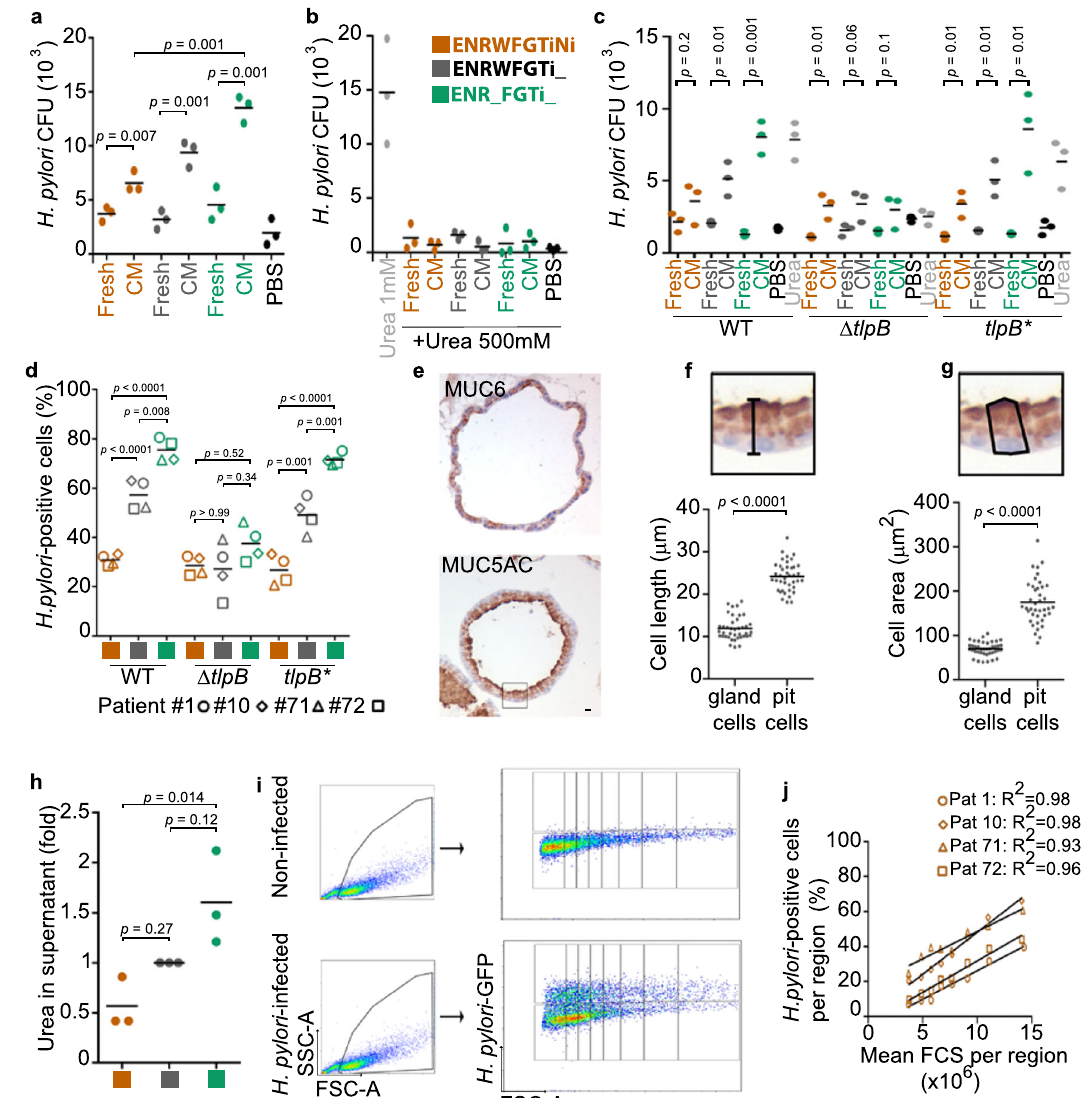
Fig. 5 | H.pylori preference for pitcells depends onchemotaxis to urea scaling with size. a – c Quanti fi cation of wild-type (wt, strain P12) bacterial chemotaxis towards conditioned media ( a ) or conditioned media plus 500mM urea ( b ). Che- motaxisby H.pylori strainG27 WT, Δ tlpB and tlpB* ( c ). d Quanti fi cationof adhered H. pylori strains G27 WT, Δ tlpB and tlpB* to organoid-derived monolayers by fl ow cytometry. e Representative immunohistochemistry images of a 3D organoid stained for MUC5AC and MUC6. Scale bar: 10 µ m. f and g Quanti fi cation of cell length ( f ) and cell area ( g ) of MUC5AC-(pit cells) and MUC6-positive cells (gland cells) in 3D organoids. h Quanti fi cation of urea concentration in organoid-derived monolayer conditioned media. Fold over control differentiation media (grey,